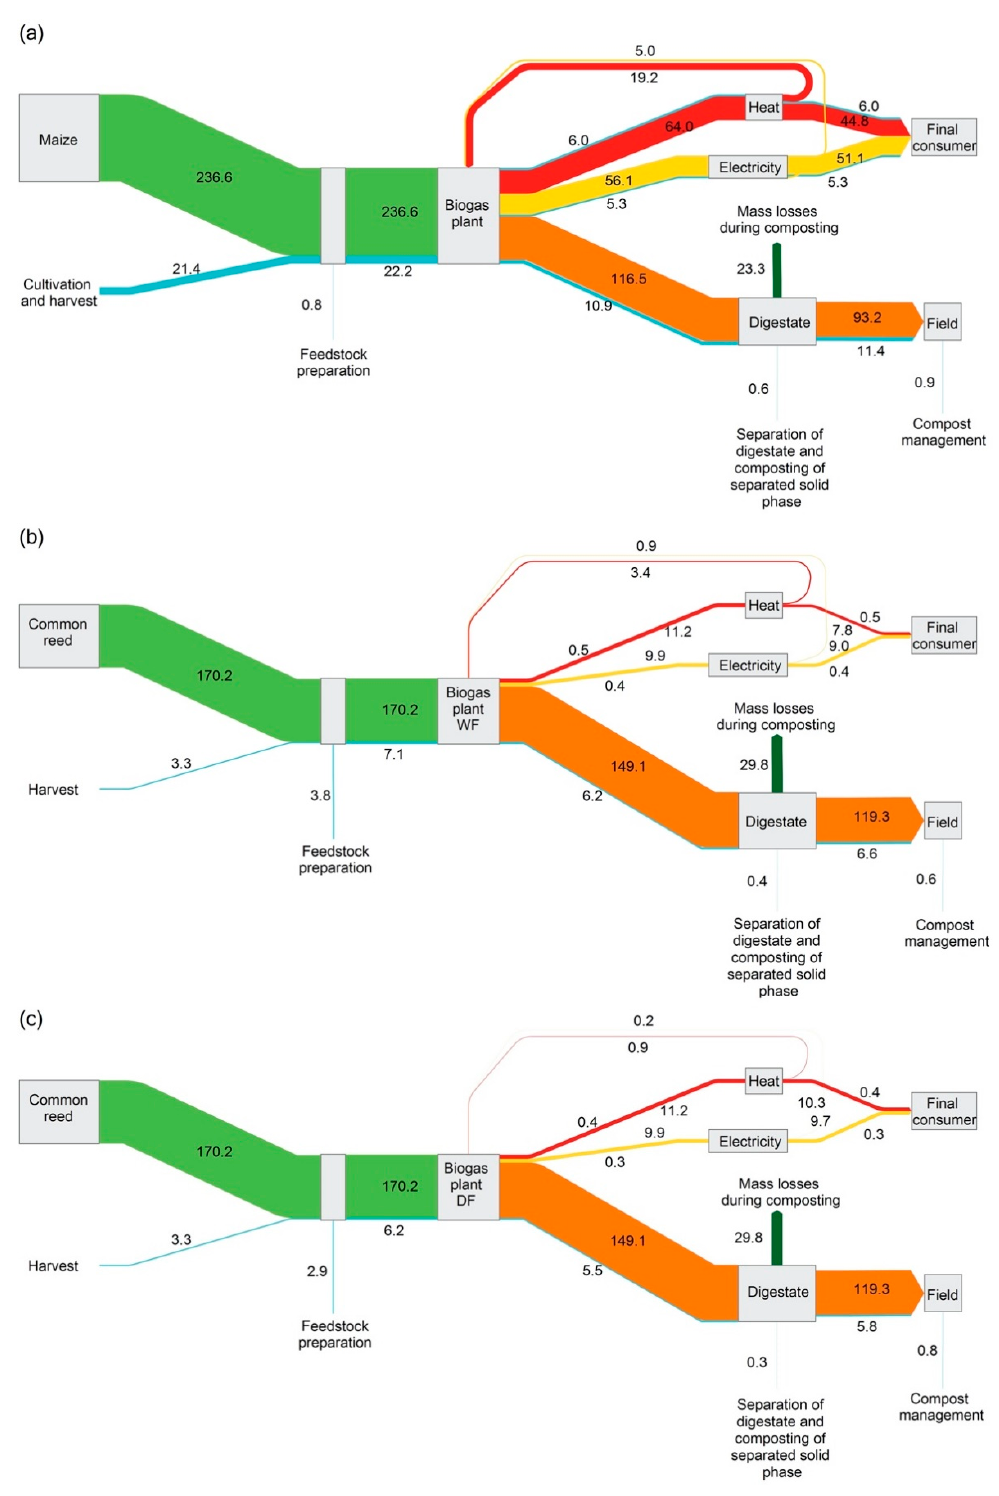
Figure 3. The flow of energy in GJ per hectare calculated for various systems: ( a ) wet fermentation of maize silage; ( b ) wet fermentation of common reed silage; ( c ) dry fermentation of common reed silage. A comparison of the two AD technologies: WF and DF pointed to the advantage and higher (by several percent) energy e ffi ciency of DF, mostly due to fewer energy requirements (e.g., no energy consumption for mixing the substrates in the fermentation